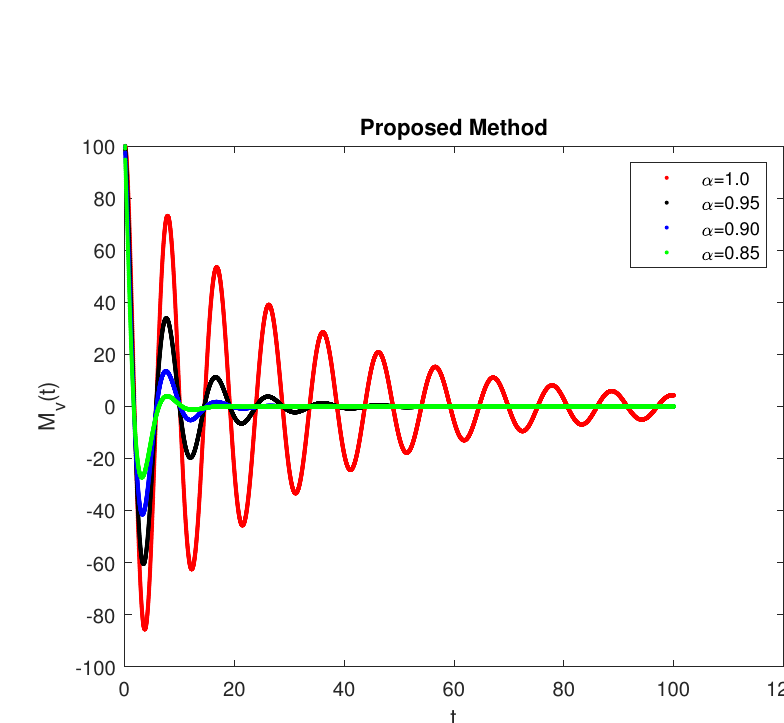
Figure 8: Numerical simulations for τ = 0.9 for ABC